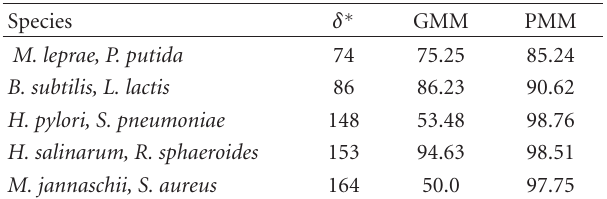
Table 3: Comparison of performance of Gaussian mixture model (GMM) with 2-way Poisson mixture model (PMM) for datasets with low δ ∗ values. Each dataset contains 50,000 reads of length 500 bp.